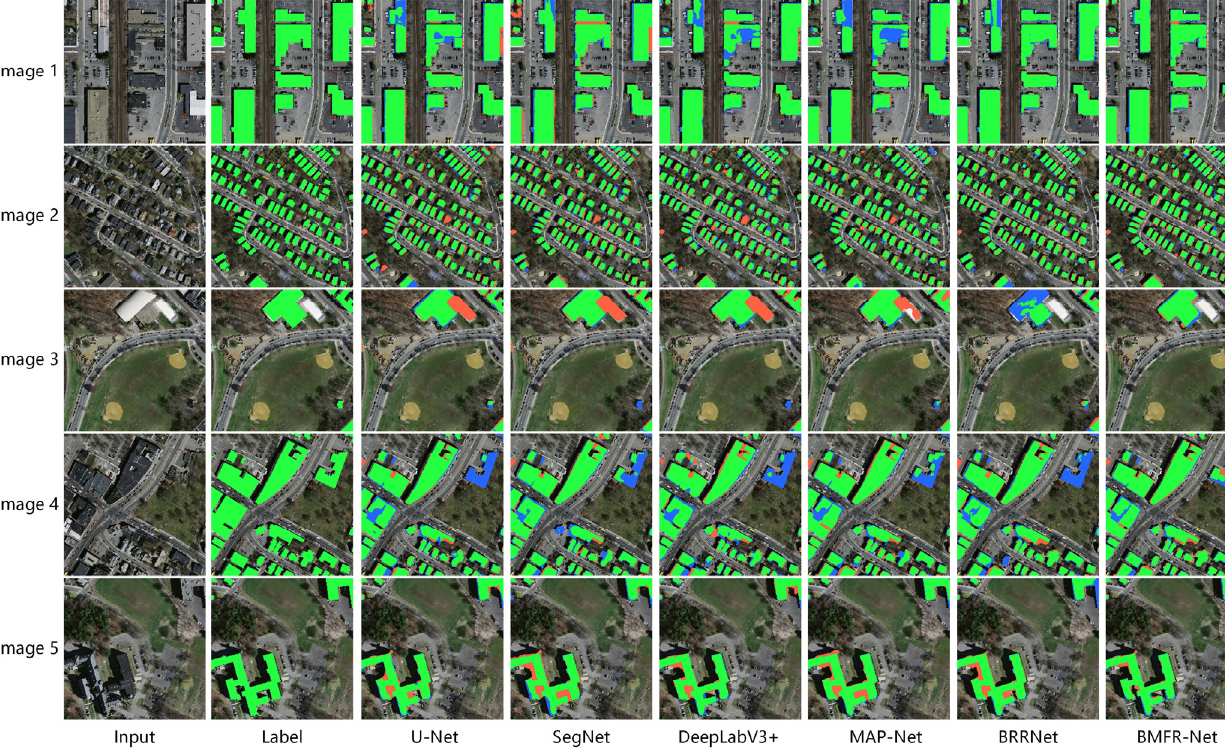
Figure 13. Typical building extraction results by different methods on Massachusetts Building Dataset. In the graph, green represents TP, red represents FP, and blue represents FN.